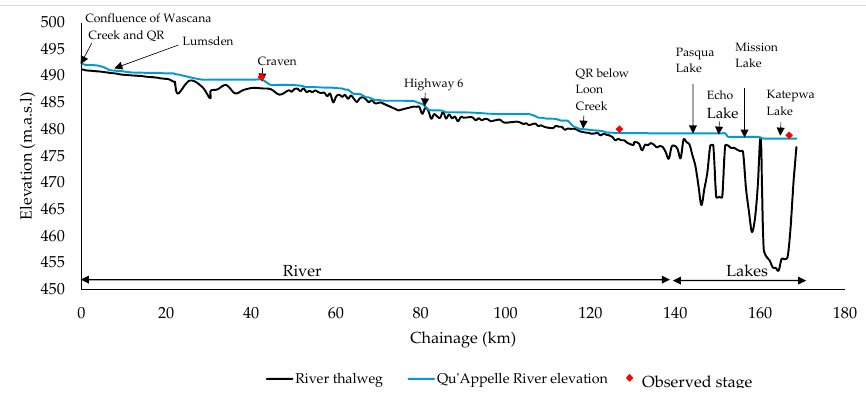
Figure 4. Longitudinal profile showing modeled surface water elevation (blue line), observed stage (red diamond square), and river thalweg (black line).